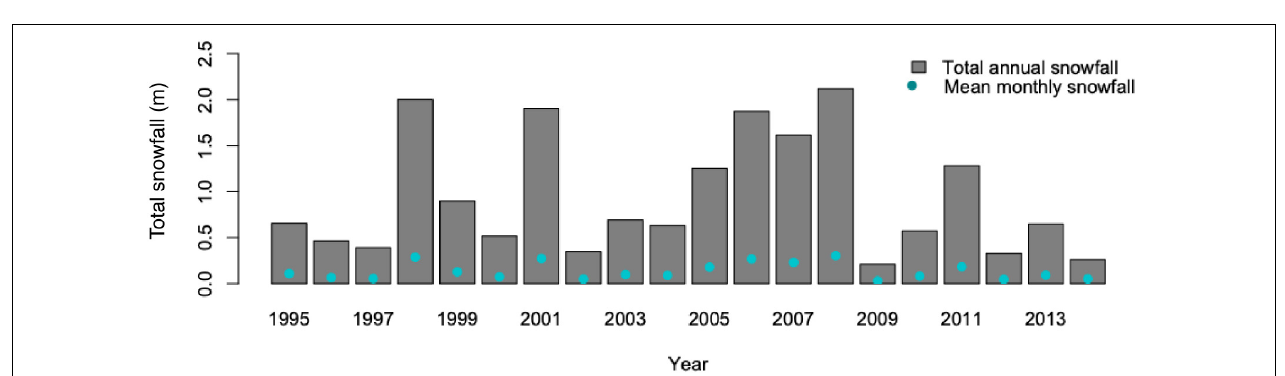
FIGURE 1 | The study area for Sitka black-tailed deer monitored from 2010 to 2013, located in the central portion of Prince of Wales Island in Southeast Alaska within the Tongass National Forest, United States.